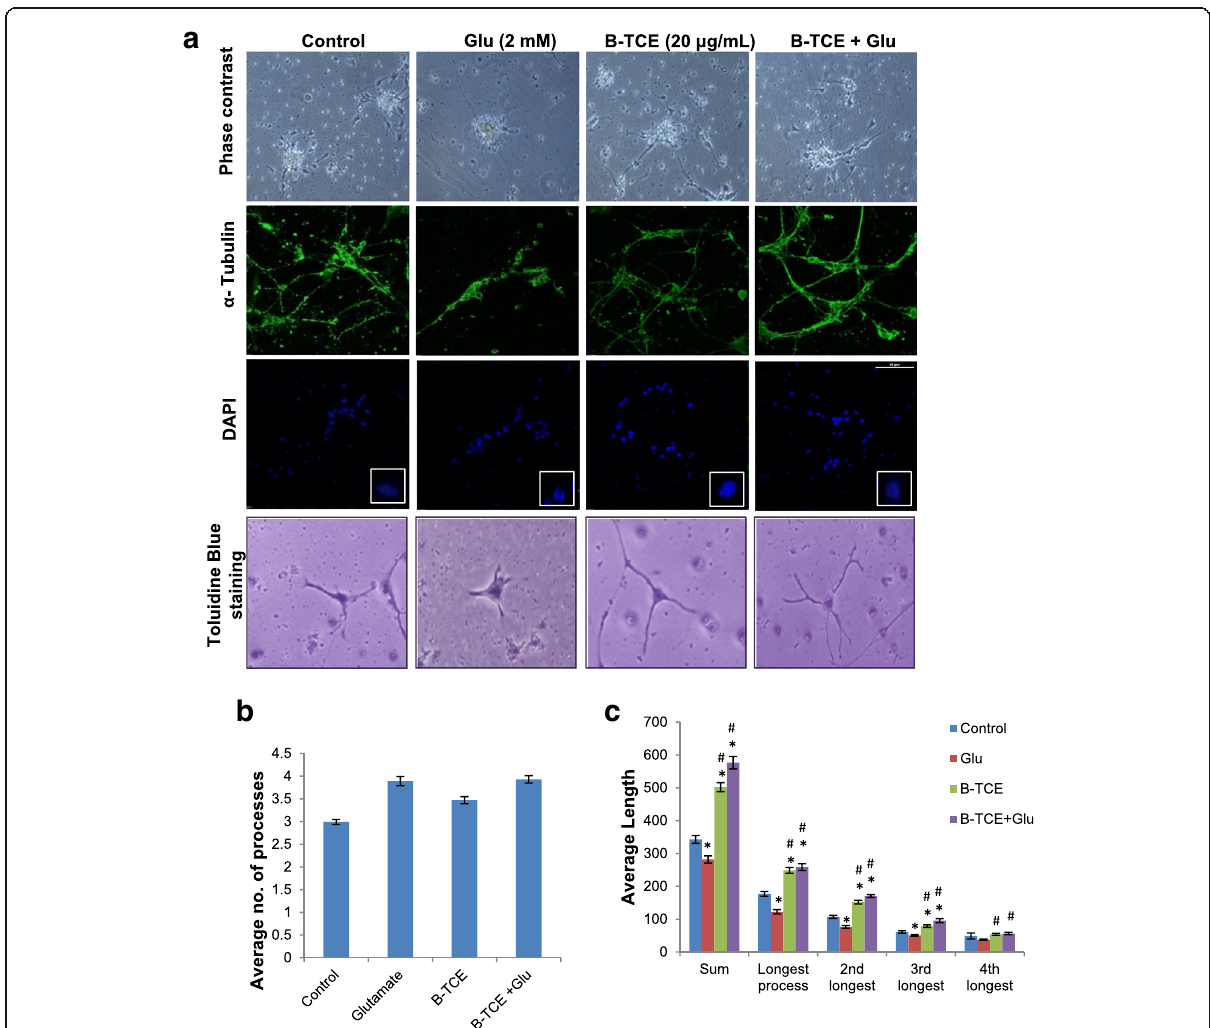
Fig. 1 B-TCE pretreatment inhibited adverse effects of glutamate on cellular and nuclear morphology. a ) Phase contrast, α -Tubulin immunostained and nuclear staining (DAPI) confocal micrographs and Toluidine blue stained Control, Glutamate (2 mM), B-TCE (20 μ g/mL) and B-TCE + Glu treated primary cerebellar neurons. b ) The histogram represents average number of processes and c ) average length of processes of primary cerebellar neurons of these four different groups. Data was compared between Control and other groups such as Glutamate, B-TCE and B-TCE + Glu ( * p ≤ 0.01) as well as Glutamate alone with B-TCE and B-TCE + Glu groups ( # p ≤